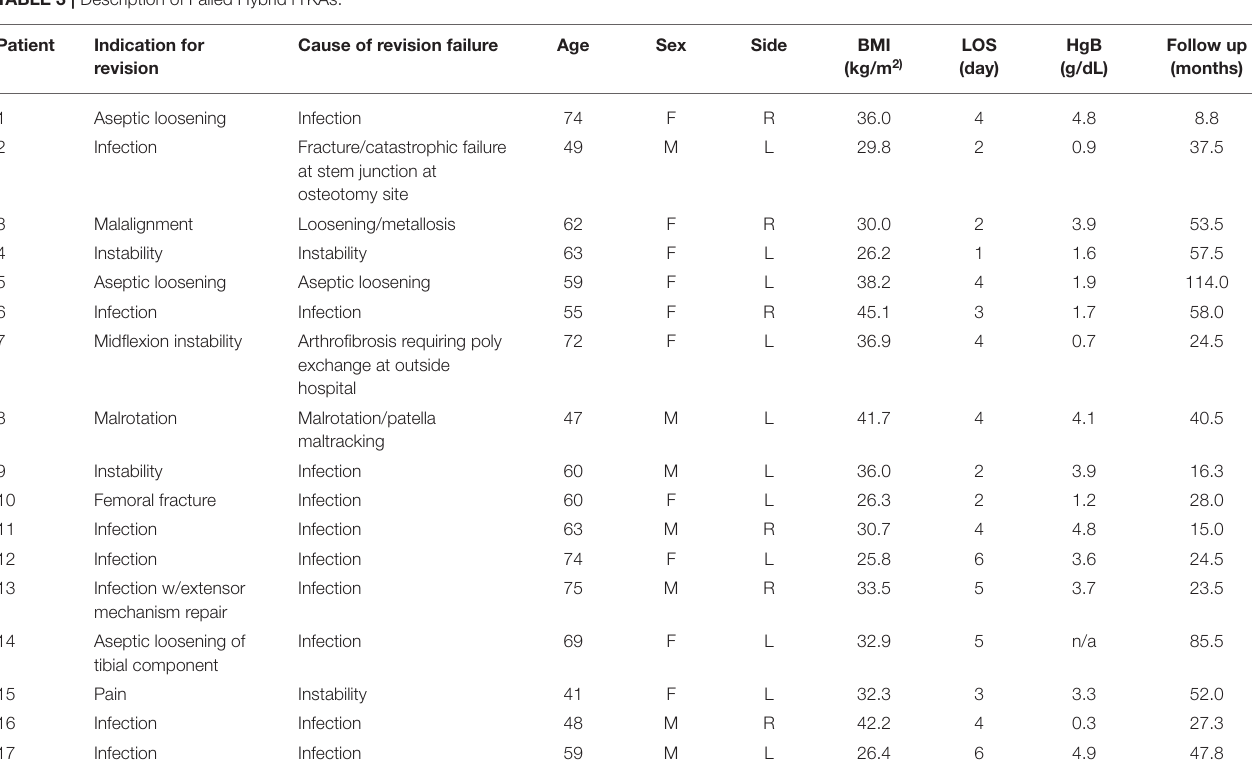
TABLE 3 | Description of Failed Hybrid